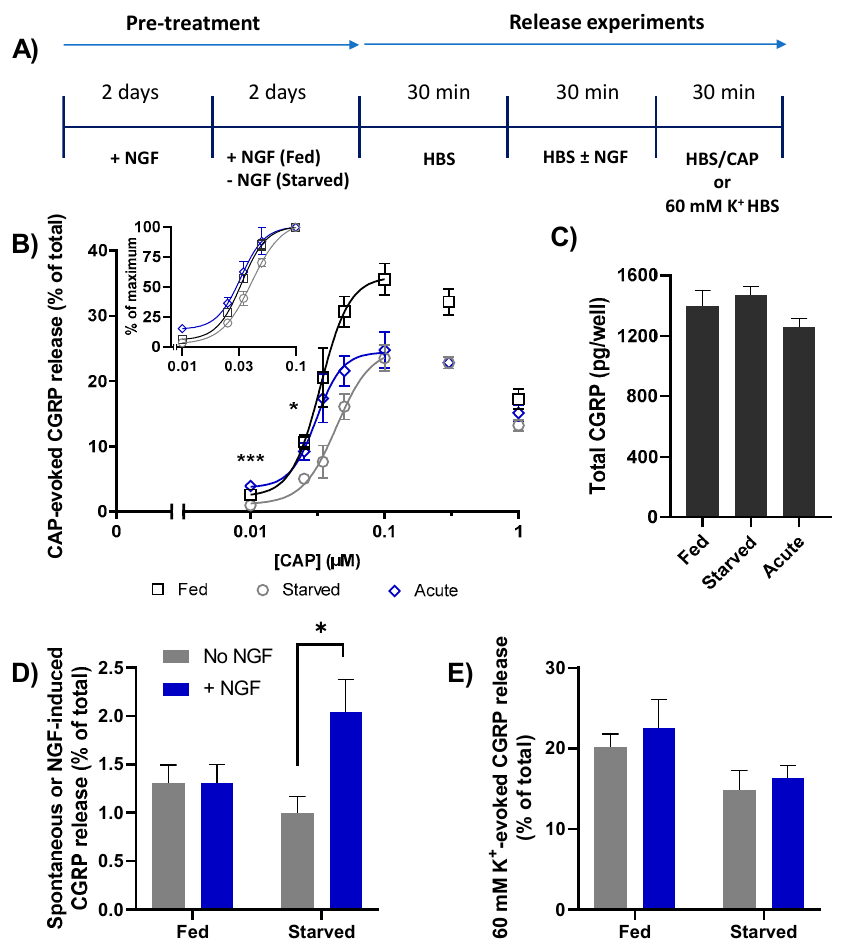
Figure 3. NGF withdrawal for 2 days from cultured TGNs reduces CGRP release stimulated by CAP; acute NGF induces exocytosis and enhances that stimulated with low [CAP]. ( A ) Timeline for pre-treatment and experimental manipulations of TGNs to determine the effect of NGF starvation and its brief re-introduction (100 ng/mL) on CGRP release under requisite conditions. ( B ) Dose-response relationship between [CAP] and CGRP release expressed as a % of total. Asterisks show significant differences between starved and NGF acutely treated cells (* p < 0.05, *** p < 0.001, n = 8, N ≥ 3, one-way ANOVA followed by Bonferroni’s post hoc test). Insert: The data obtained with 0.01–0.1 µM CAP replotted as a % of the requisite maximum release evoked by 0.1 µM. ( C ) Total CGRP contents. ( D ) Spontaneous or NGF-induced CGRP released from fed and starved cells (as indicated on abscissa) during the second of three 30 min. periods during which they were exposed to HBS only (grey bars) or HBS containing 100 ng/mL NGF (blue bars). Exposure of starved (but not fed) cells to NGF induced a significant increase in CGRP release (* p < 0.05, n = 9, N = 3, unpaired two-tailed Welch test). ( E ) In separate experiments, TGNs were incubated for 30 min. with/without NGF and then stimulated with 60 mM K + HBS. Data is presented as mean +